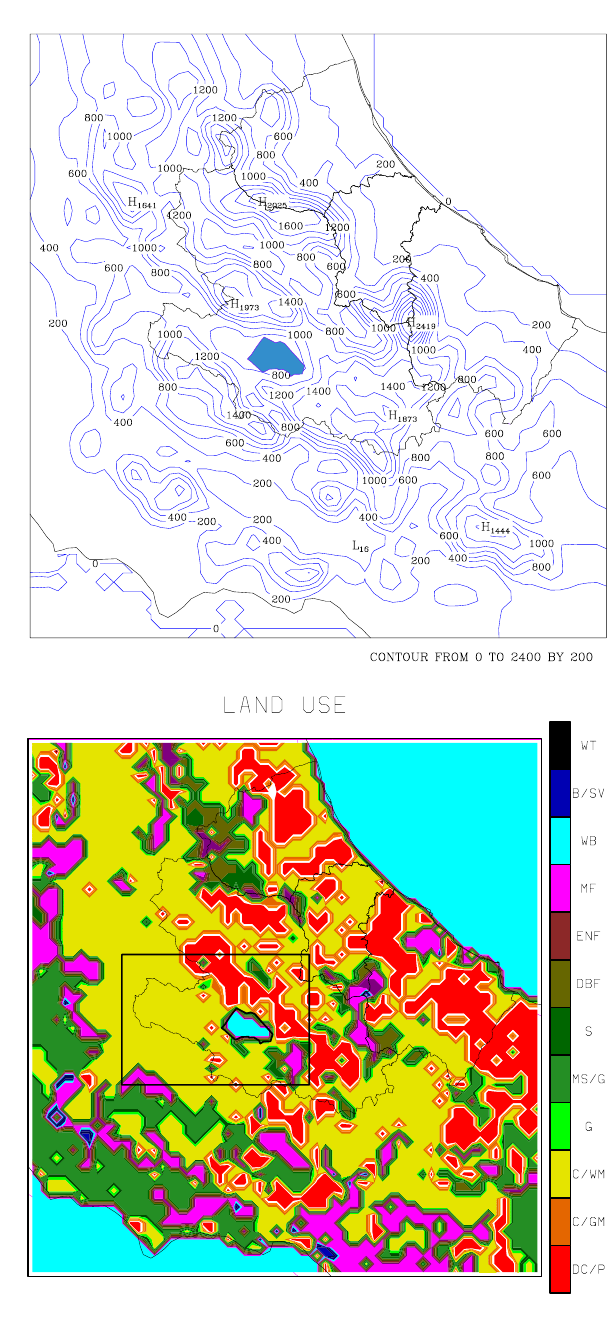
Fig. 2. Model topography (a) and land-use type (b) for the in- ner domain and area covered by the Fucino Lake (in blue). Units are m for topography. Also shown in Fig. 2b is a sub-region sur- rounding the Fucino Lake used for the calculations reported in Ta- ble 1. Land surface types in Fig. 2b are: DC/P = Dryland Crop- land and Pasture; C/GM = Cropland/Grassland Mosaic; C/WM = Cropland/Woodland Mosaic; G = Grassland; MS/G = Mixed Shrub- land/Grassland; S = Savannah; DBF = Deciduous Broadleaf Forest; ENF = Evergreen Needleleaf Forest; MF = Mixed Forest; WB = Water Bodies; B/SV = Barren or Sparsely Vegetated; WT = Wooded